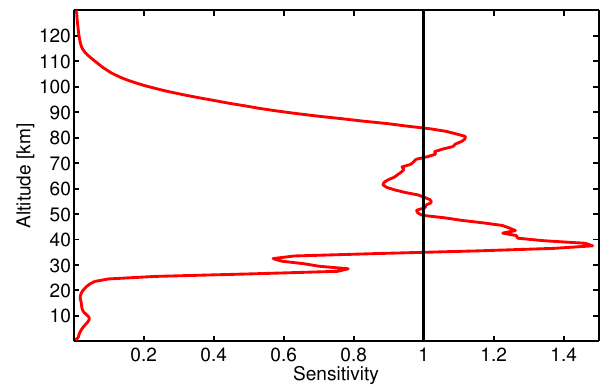
Fig. 1. Average sensitivity of the KIMRA measurements as given by the area under the AVK functions. See text and Hoffmann et al. (2011) for